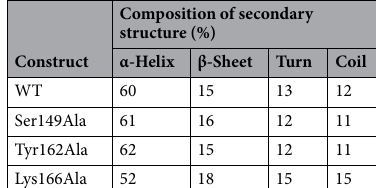
Composition of secondary structure Construct